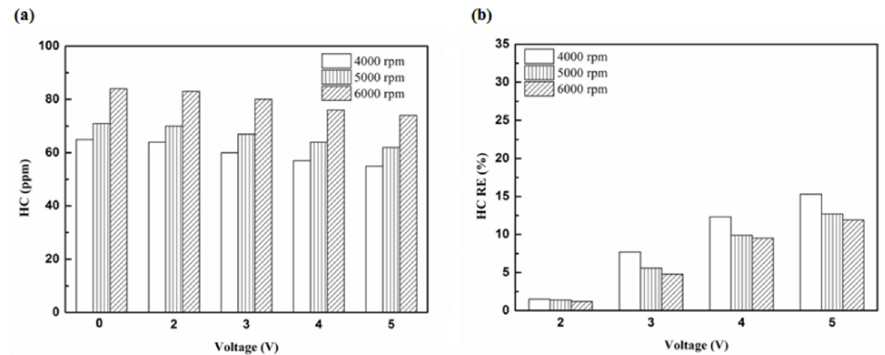
Figure 5. The HC ( a ) emission values and ( b ) removal efficiency (RE) using platinum in the front of the exhaust pipe.